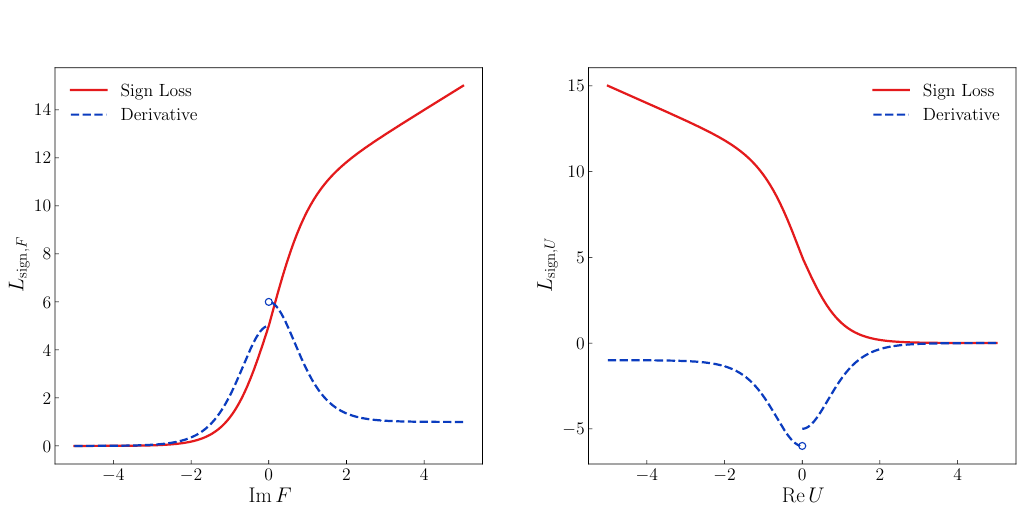
Figure 6: Illustration of the sign loss and its derivative for the F (left) and U (right) = 1 / part for Y = 10 and X { F , U }